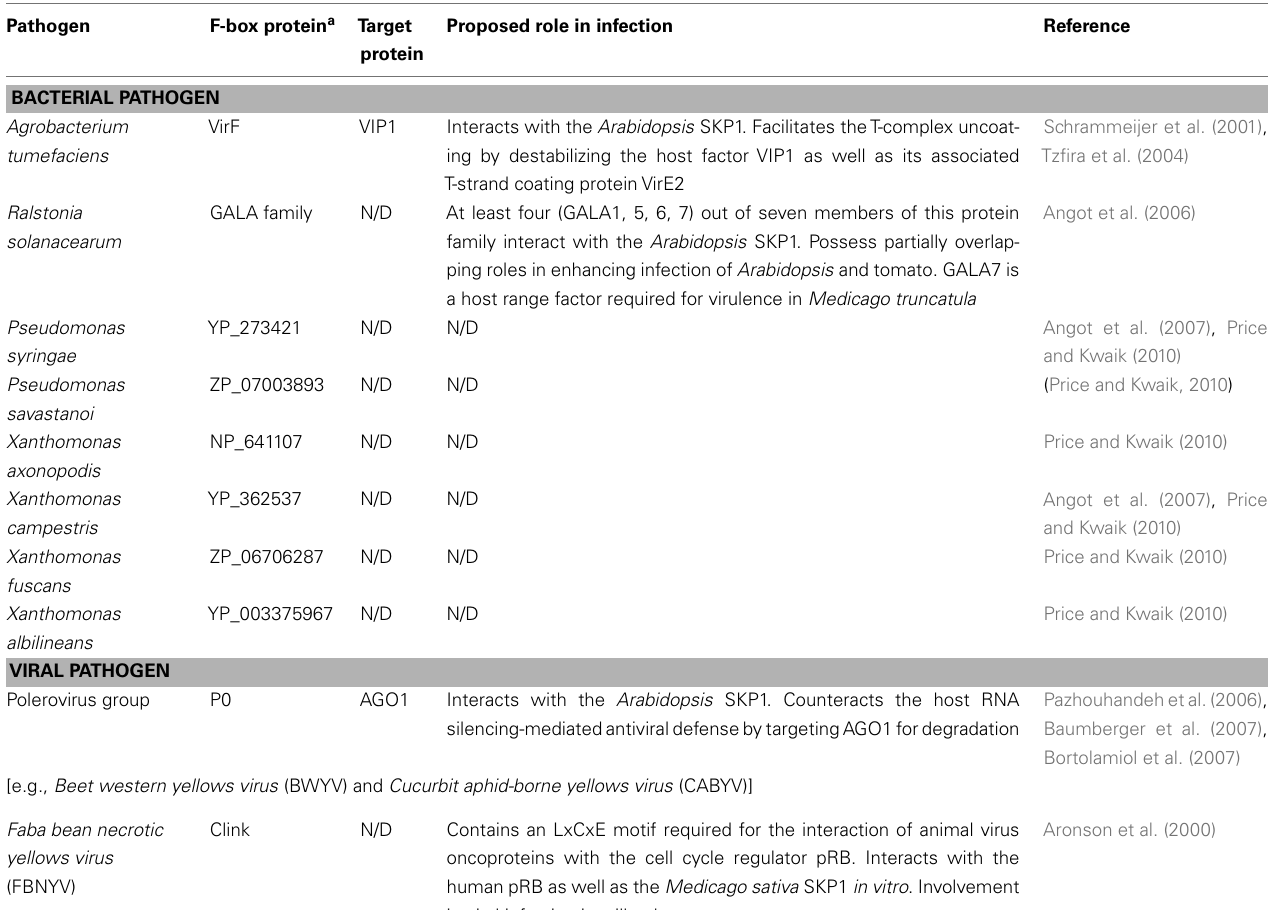
Table 1 | Summary of F-box proteins encoded by plant